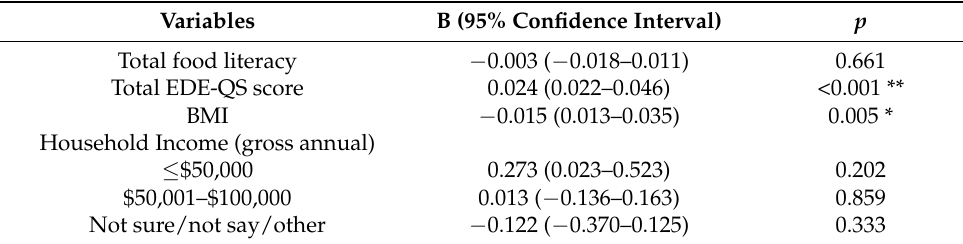
Table 4. Multiple regression analysis scoring for food literacy, eating disorder symptoms, BMI and household income predicting level of parental restriction